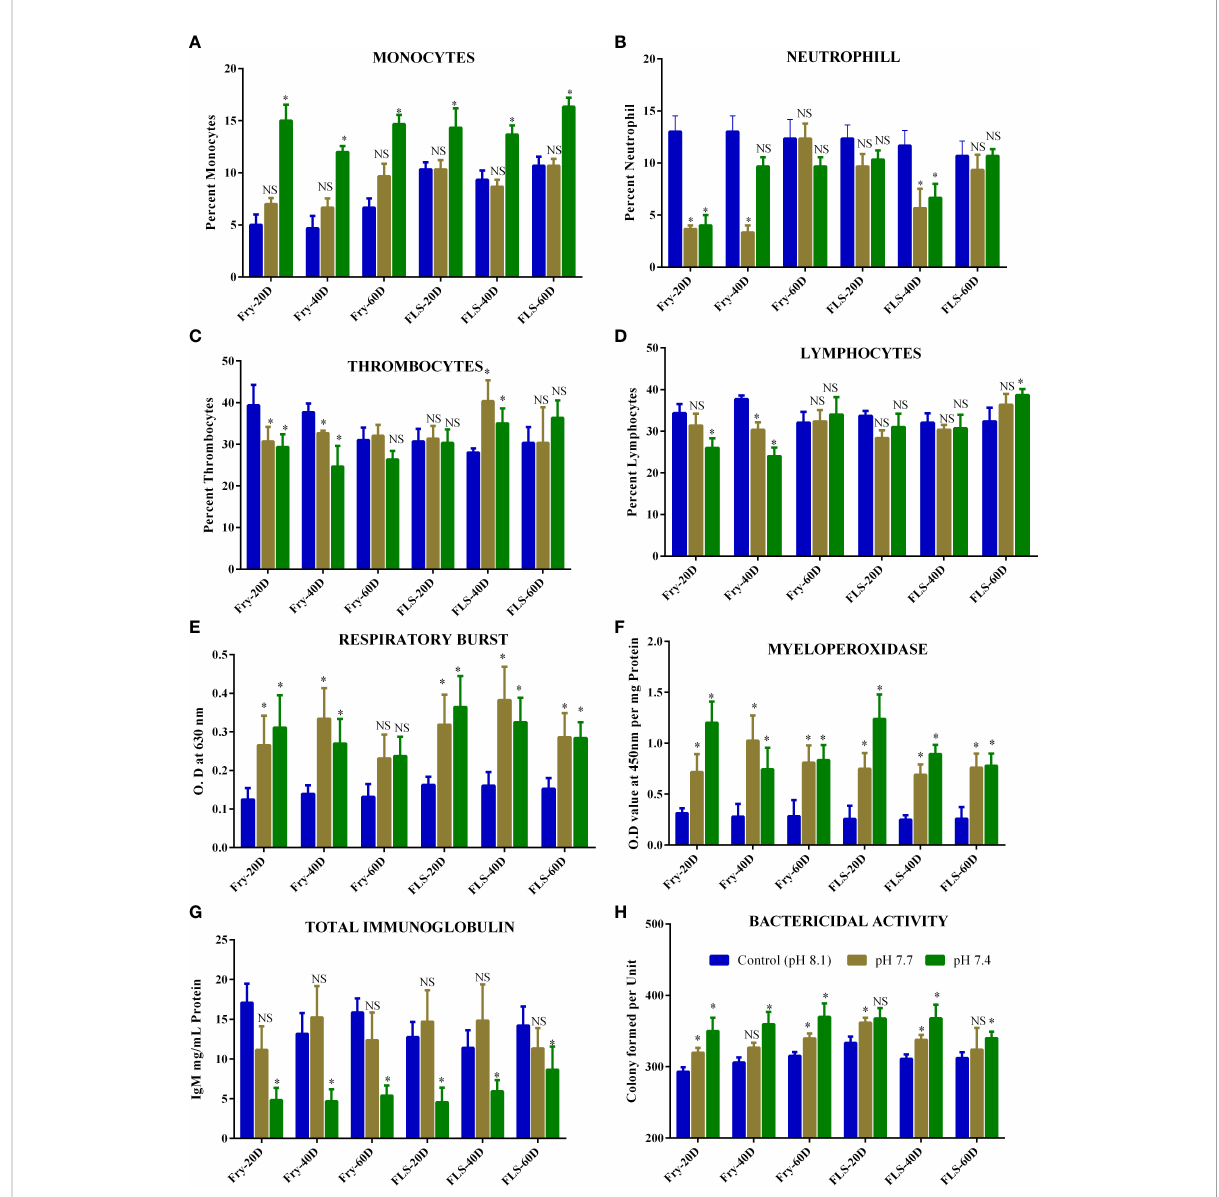
FIGURE 1 (A-D) is the data representing the biochemical components such as (A) Monocytes (B) Neutrophil (C) Thrombocytes (D) Lymphocytes (E) Respiratory burst (F) Myeloperoxidase (G) Immunoglobulin (H) Bactericidal activity in fi sh fry and fi ngerling of Asian seabass exposed for 60 d under different acidi fi ed conditions. Each bar represents mean ± standard deviation of six samples. Two-way analysis of variance followed by Tukey ’ s post hoc test was used. The asterisk indicates signi fi cant difference between the exposure and control groups whereas NS letters No signi fi cant difference ( p < 0.05) between different